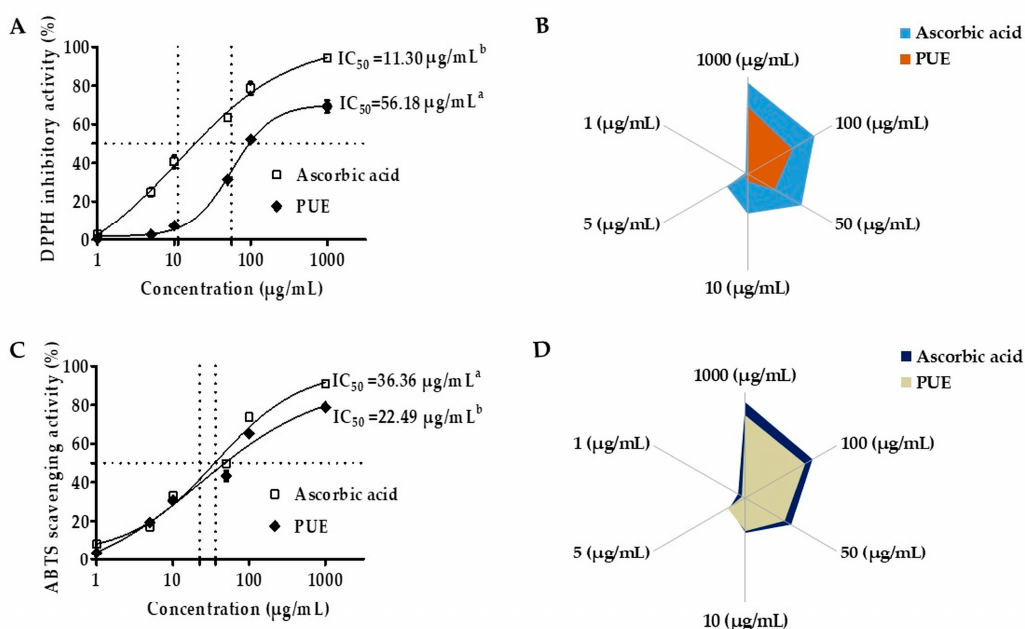
Figure 4. Antioxidant effects of Pyrus ussuriensis Maxim ethanol (50%) extract in the 2,2-diphenyl-1-picrylhydrazyl (DPPH) and 2,2 (cid:48) -azino-di-(3-ethylbenzothiazoline)-6-sulfonic acid (ABTS) assays. ( A ) IC 50 values and ( B ) the % free radical (DPPH) scavenging activity of PUE. The sample and DPPH solutions were incubated at 37 ◦ C and the absorbance was measured at 517 nm. Ascorbic acid was used as a positive control. For the ABTS assay ( C , D ), after mixing the ABTS solution and the samples, the absorbance at 734 nm was measured. The results are expressed as the mean % inhibition ± SEM and IC 50 ( n =